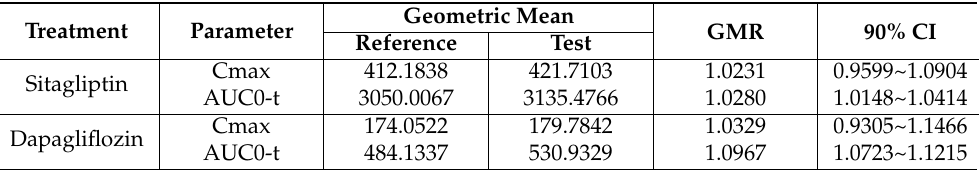
Table 17. GMR, 90% confidence interval and geometric mean of pharmacokinetic parameters ( n = 36). Treatment